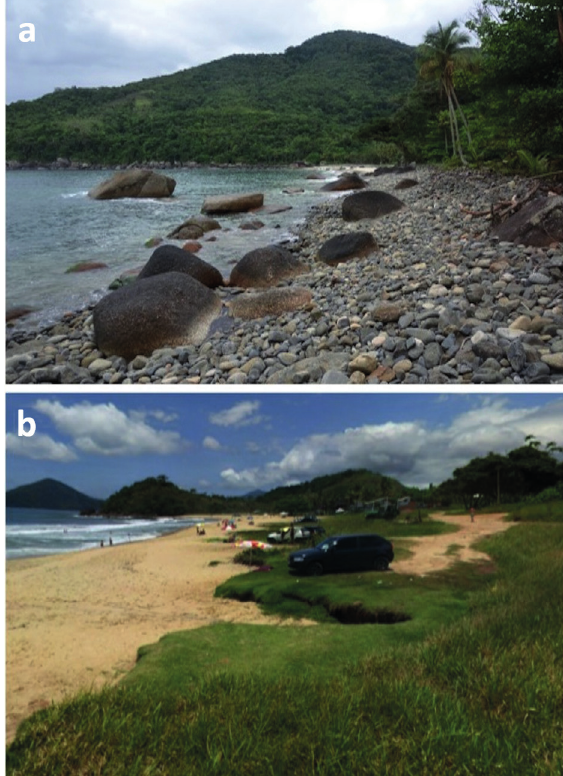
Figure 6 - representative geosite related to the GF Geomorphology and Landscape Evolution. Geosite “Baepi Peak” - Landform developed on Late Cretaceous alkaline magmatic rocks. a ) General view of the relief formed on alkaline batholiths. Baepi Peak on the left side. (Photo: E. Santos); b ) Detail of the peak showing E-W